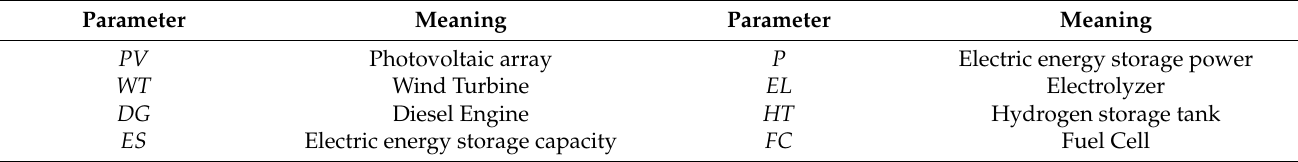
Table 2. Decision Variable Parameter Cross